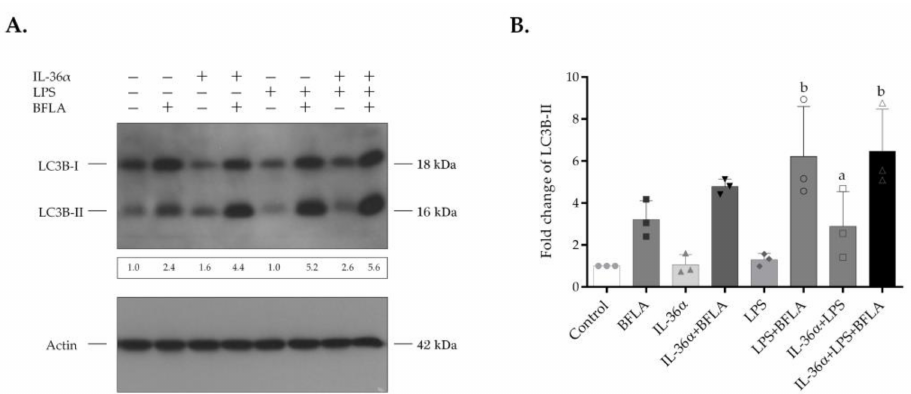
Figure 4. IL-36 α and LPS cooperatively stimulate the autophagic flux. THP-1 cells were treated with IL-36 α , and LPS alone or in combination for 2 h and then exposed to 100 nM bafilomycin A1 for another 4-h period. The total protein extracted was analyzed for LC3B expression by Western blot analysis. ( A ) Western blot analysis showing increased autophagic flux in cells treated with IL-36 α , and LPS alone, or in combination. The ratios of the protein levels were calculated, and expressed as fold change, shown below each lane. Results are representative of three independent experiments. ( B ) The values on the bar graph denote the means ± SD of the results of three independent experiments. p values were calculated by the ANOVA test with the Sidak post-test. a p < 0.05 vs. control, b p < 0.05 vs. BFLA control. BFLA, bafilomycin